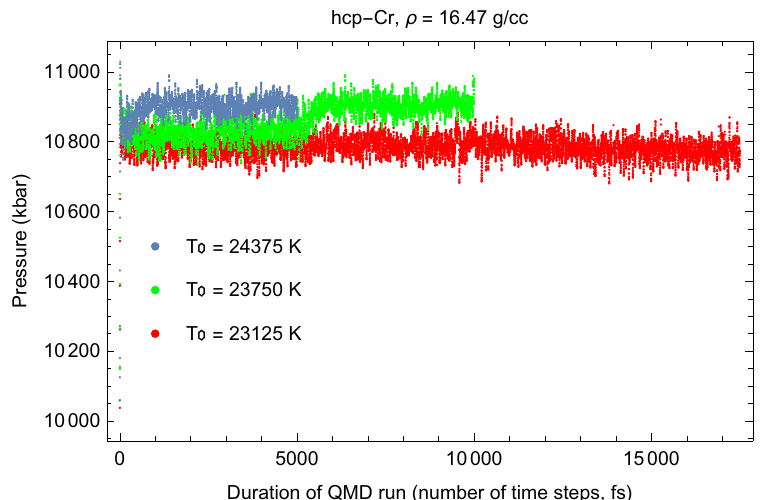
Figure 5. The same as in Figure 4 for the time evolution of pressure (in kbar; 10 kbar = 1 GPa). During melting, P increases from ∼ 1080 GPa for the superheated state to 1093 GPa for the liquid at the corresponding melting